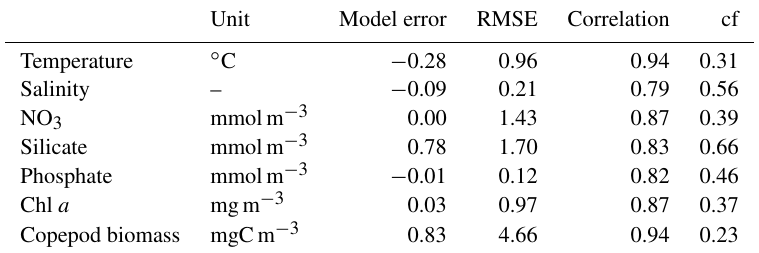
Table 2. Statistics for seasonal comparison between observational data (monthly climatology) and model data (monthly average from 2005 to 2018) at the Disko Bay station. N = 12 for copepods; N = 11 for temperature, salinity, and Chl a ; and N = 10 for other variables (see Fig. 4). All correlations were significant ( p< 0 .